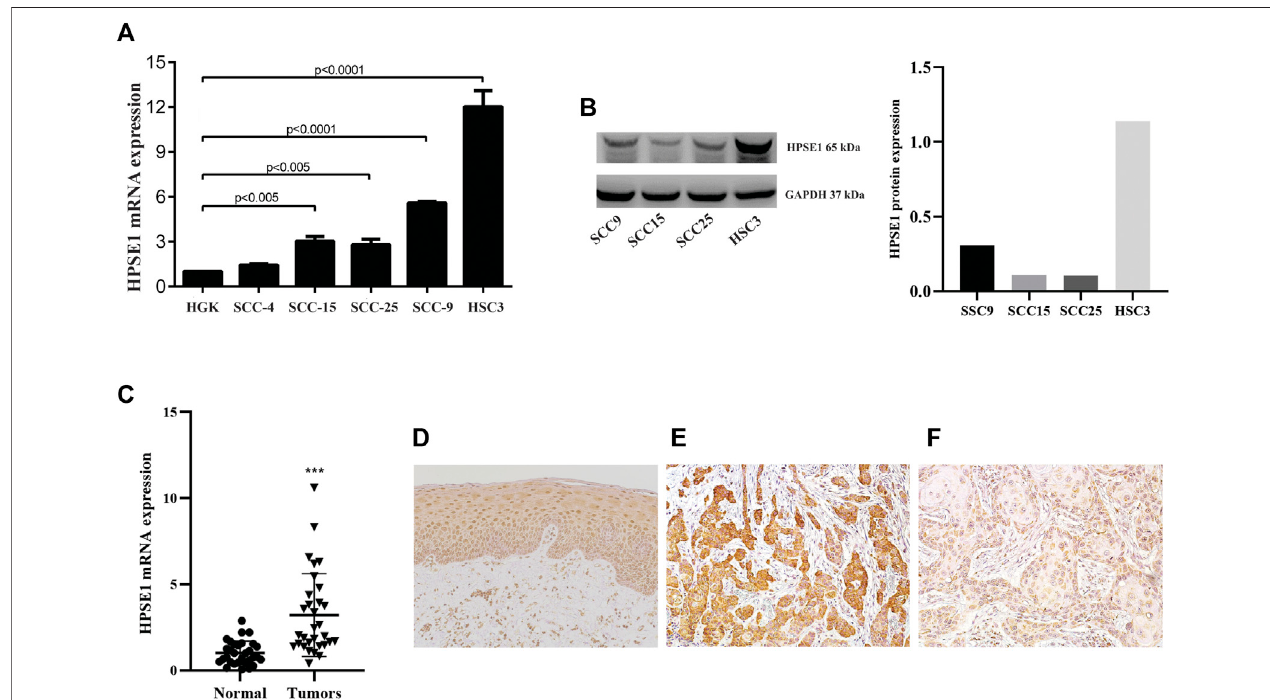
FIGURE1| HPSE1 isoverexpressedinOSCCs patient samplesand OSCC-derived celllines.Total RNAfrom fresh samplesand cell lines wasconverted tocDNA andsubjectedtoqPCR.Forgeneexpressionanalysisoftissuesamplesrelativequanti fi cationwasbasedonthecomparisonofapoolof fi venormaloraltissues,whilethe spontaneouslyimmortalizedbutnon-transformedepithelialcelllineHGKwasusedasreferenceforcomparisonwithOSCC-derivedcelllines.ThelevelsofHPSE1mRNA were signi fi cantly higher in OSCC cell lines compared with HGK cells (A) . The high expression levels of protein HPSE1 were con fi rmed on OSCC-derived cell lines by Western Blot analysis (B) . The levels of HPSE1 mRNA were also signi fi cantly higher in OSCC tissue samples compared to normal oral mucosa (C) . Representative imagesinahigh-power fi eld(200×) ofimmunohistochemicalanalysis forHPSE1 inNormal oraltissue (D) and OSCC tissue preparationscon fi rmed its higher expression at protein level; with a distinct cytoplasmic distribution and intensity in oral cancer samples expressing both higher (E) and lower (F) levels of HPSE1. Results were statistically determined by ANOVA followed by Tukey multiple comparison test, where ** p < 0.005, *** p < 0.001, and **** p < 0.0001.